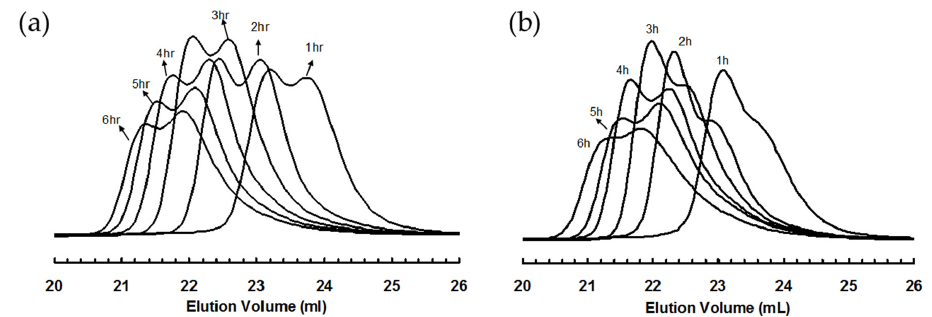
Figure 4. GPC elution curves for polyethylene samples taken at different polymerization time in ethylene “living” polymerization using ( a ) 3a ; and ( b ) 3b , at 5 °C and 400 psi in cholorobenzene. Table 2. Ethylene polymerization using 3a at 5 ◦ C and 400 psi in chlorobenzene a .